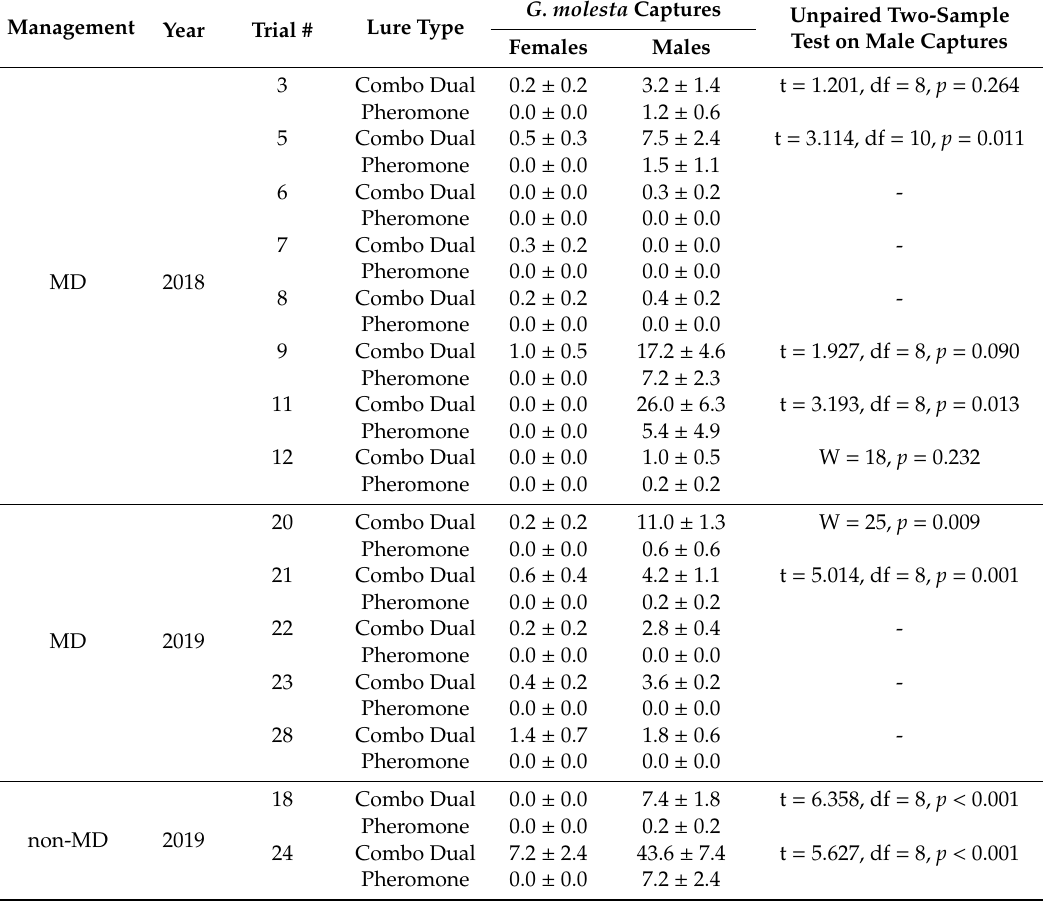
Table 6. Grapholita molesta captures in fifteen trials of lure comparison conducted in mating disruption (MD)-treated and -not treated peach and nectarine orchards in Italy during late fruit development crop stage in 2018–2019. Mean ( ± SEM) of total moth captures over 6–8 weeks of trial duration. Monitoring traps were either baited with Pherocon ® OFM Combo Dual (Combo Dual) or Pherocon ® OFM L 2 (Pheromone), both Tr é c é Inc.